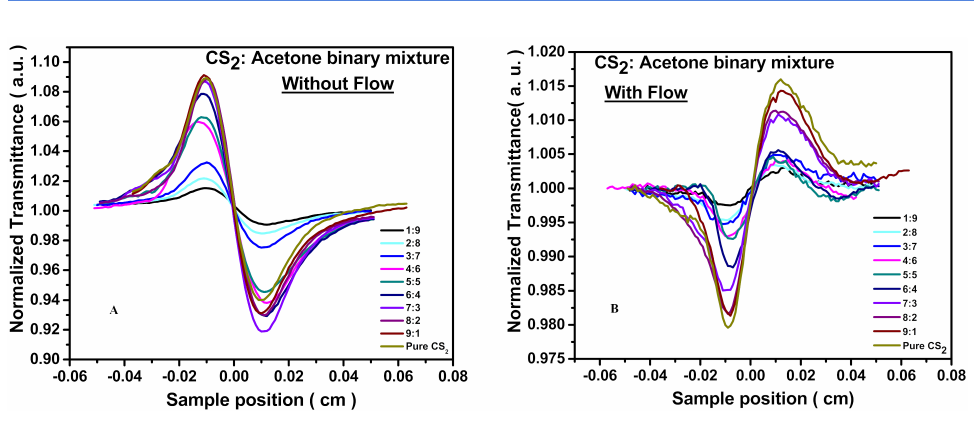
Figure 3 CAZS trace for the binary liquid mixture of carbon disulfide with acetone under ‘‘without flow’’ and ‘‘with flow’’ conditions. Full-size DOI: